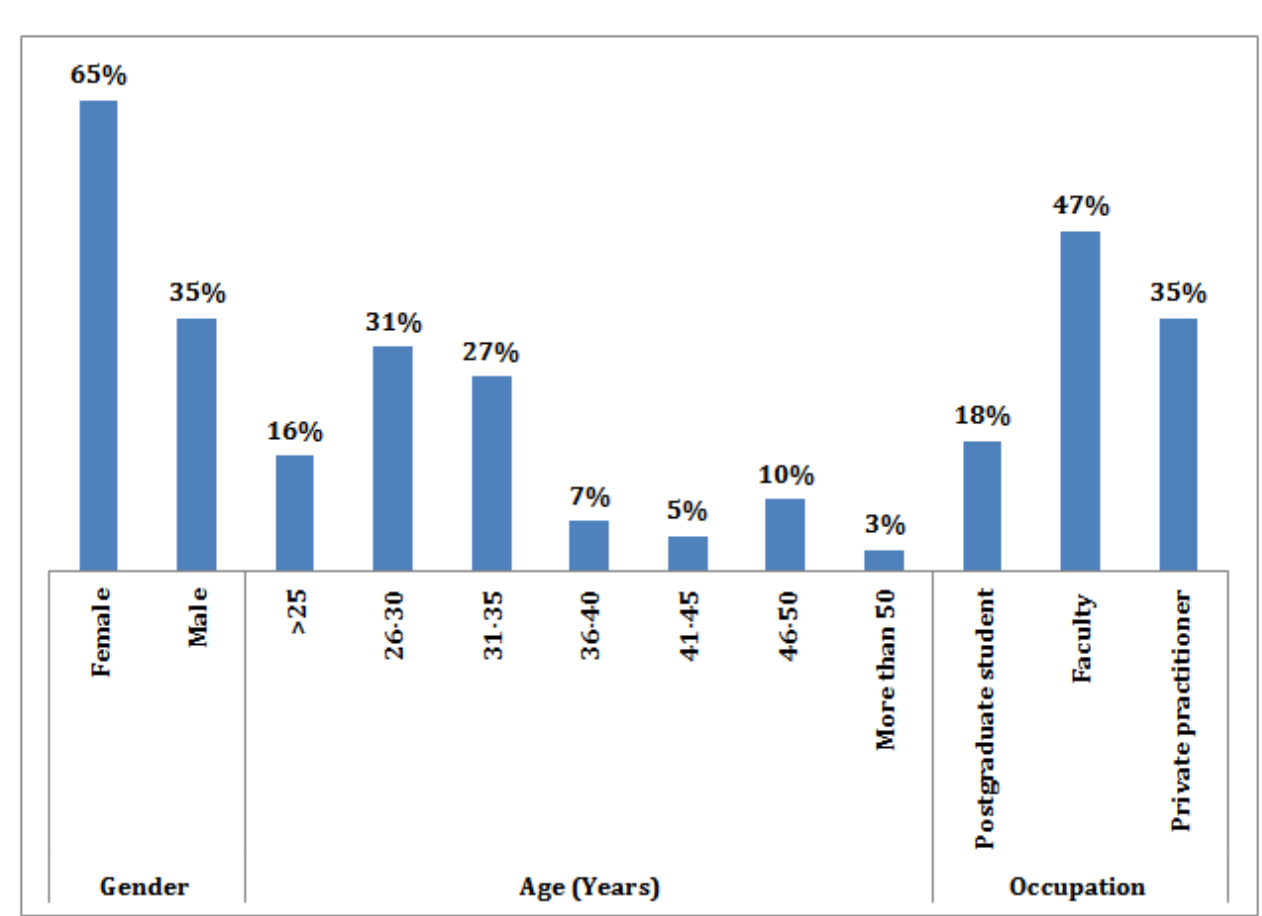
Figure 1. Demographic characteristics of the study population.